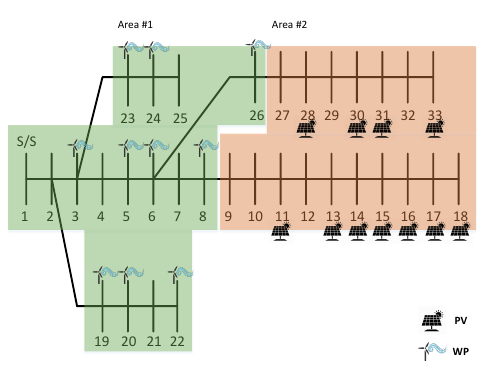
Figure 29. Snapshot—mean value—Scenario #2